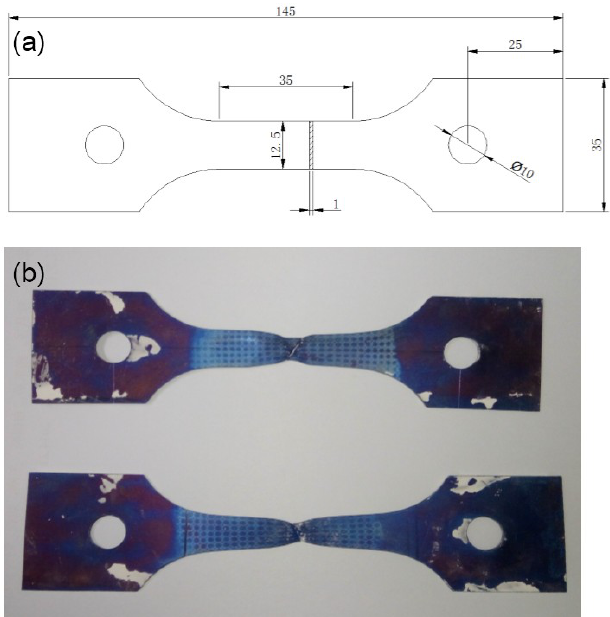
Figure 1. ( a ) Geometry of tensile specimen (unit: mm), ( b ) specimen after fracture.